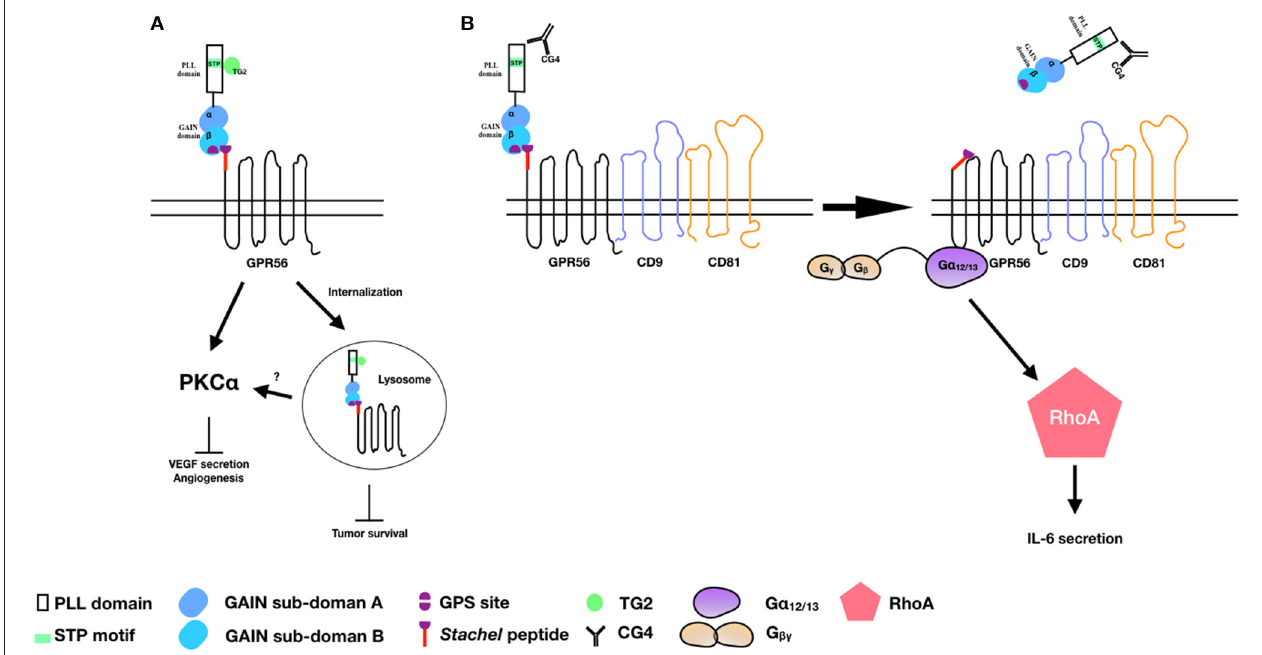
FIGURE 2 | The activation and signaling pathways of GPR56 in melanoma cells. (A) TG2 binding induces GPR56 receptor internalization to inhibit melanoma growth and angiogenesis. It is also likely that GPR56 can signal via PKC α to inhibit VEGF production and angiogenesis through TG2 binding. (B) The CG4 mAb binds to GPR56 in the presence of CD9/CD81, causing NTF shedding and the subsequent activation of CTF by the Stachel peptide. The signaling is mediated through the G α 12 / 13 and RhoA pathways, leading to IL-6